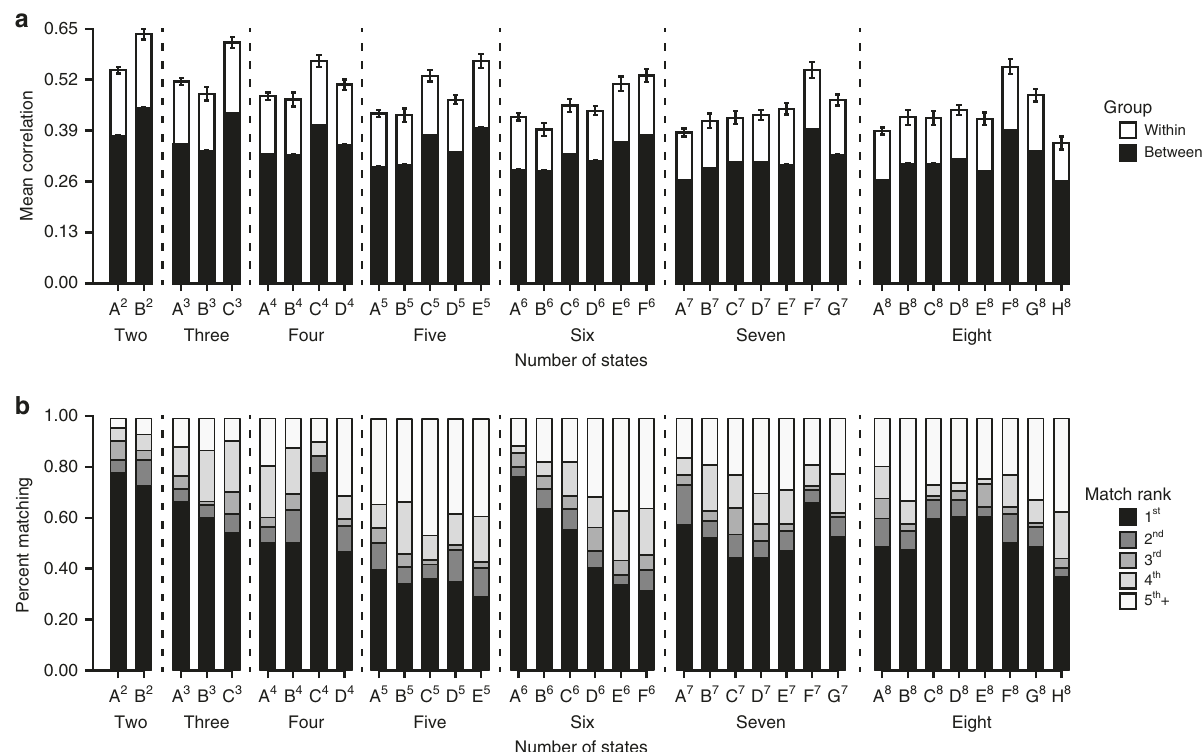
Fig. 5 Brain states are reliably expressed and can be used to identify individual participants. a Mean rho values within and between subjects across visits for all stable dynamic states. Correlation matrices from participants who had at least two scans within 6 months of each other ( n = 79) were concatenated, and a Pearson correlation was computed for scan 1 relative to scan 2. b Permutation and correlation analyses 27 revealed that dynamic states are consistent within individuals over time. Identi fi cation rank accuracy is shown for each state in a subgroup of participants scanned on two different days within 6 months ( n = 79). Rank denotes the order of similarity of a participant ’ s visit 1 to their visit 2, with 1 being a perfect identify